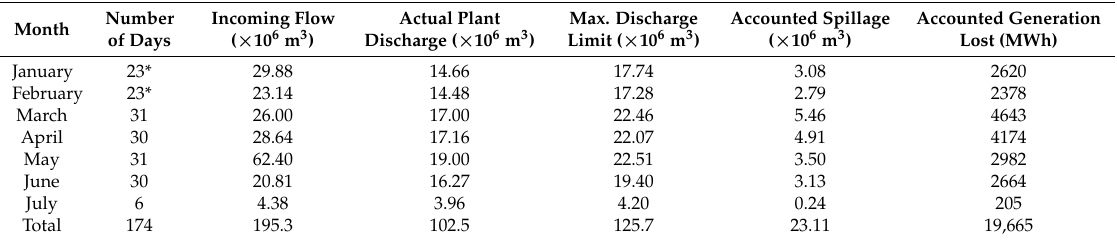
Table 6. Generation data prior to utilization of the new controller (3 January–6 June 2013).